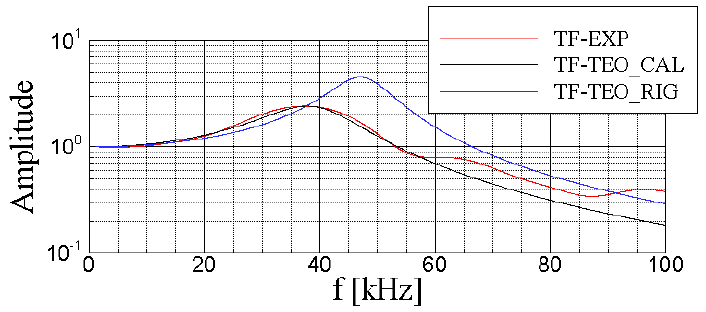
Figure 8. Impact of temperature of tests with respect to calibration on FRAPP transfer function.